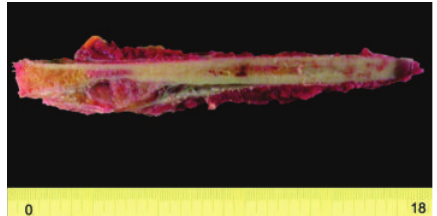
Figure 4: Macroscopic preparation that shows the resected 21cm of the tibial